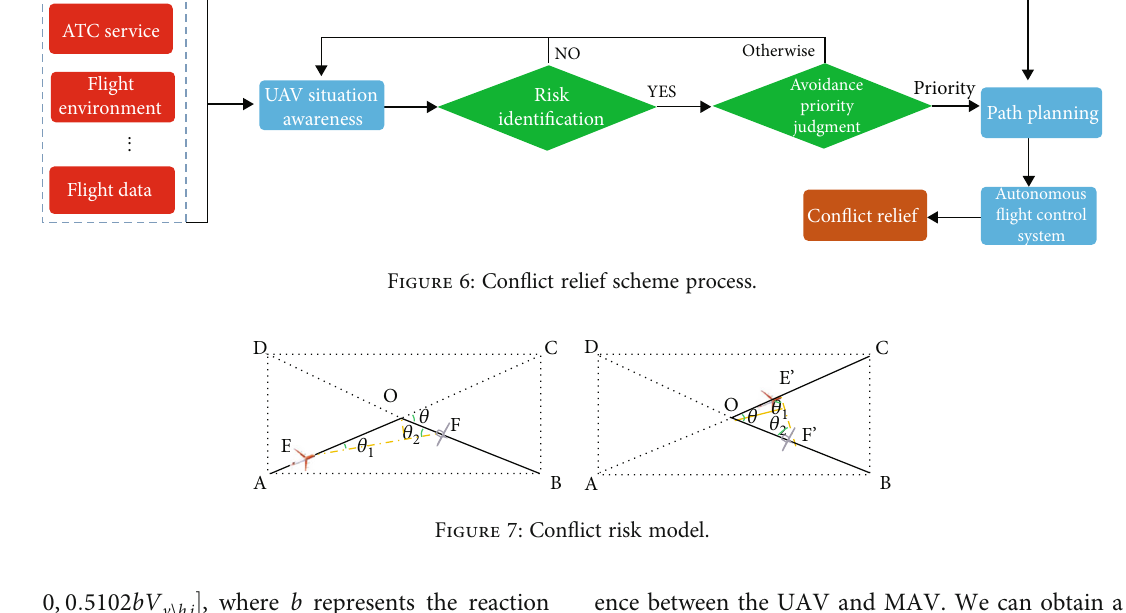
Figure 7: Con fl ict risk